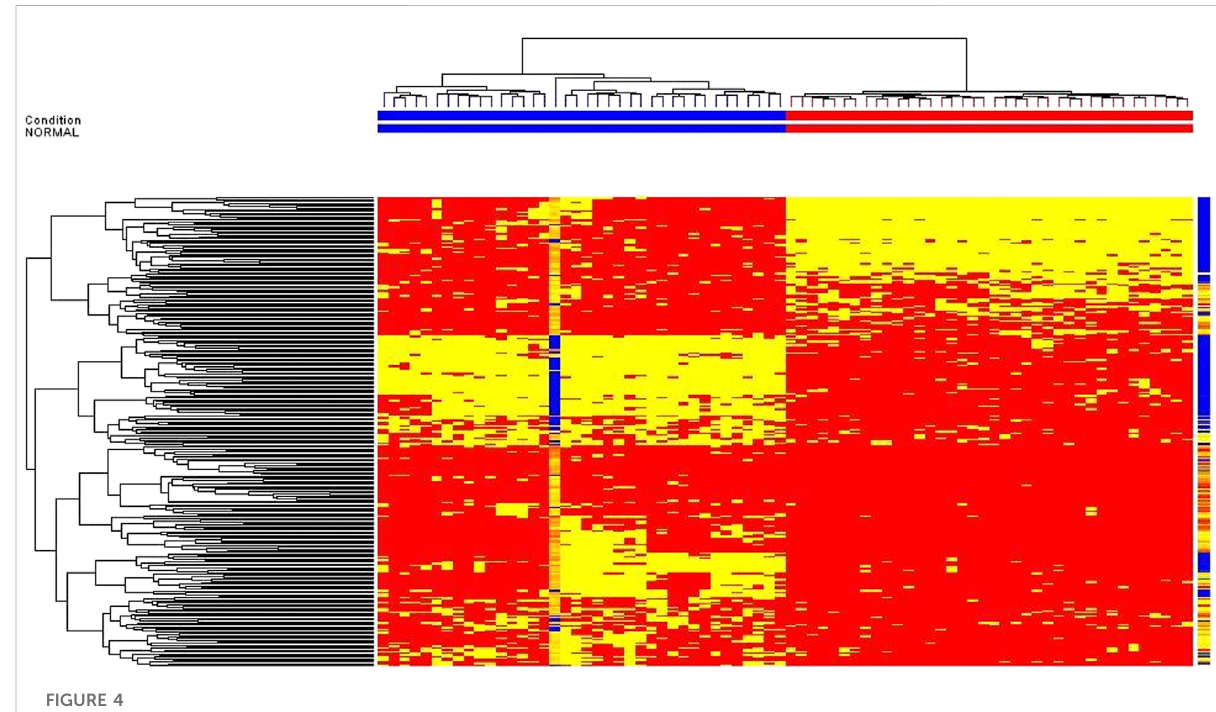
FIGURE 4 Hierarchical cluster analysis for untargeted metabolomic pro fi ling of healthy volunteers vs patients before HAART treatment.